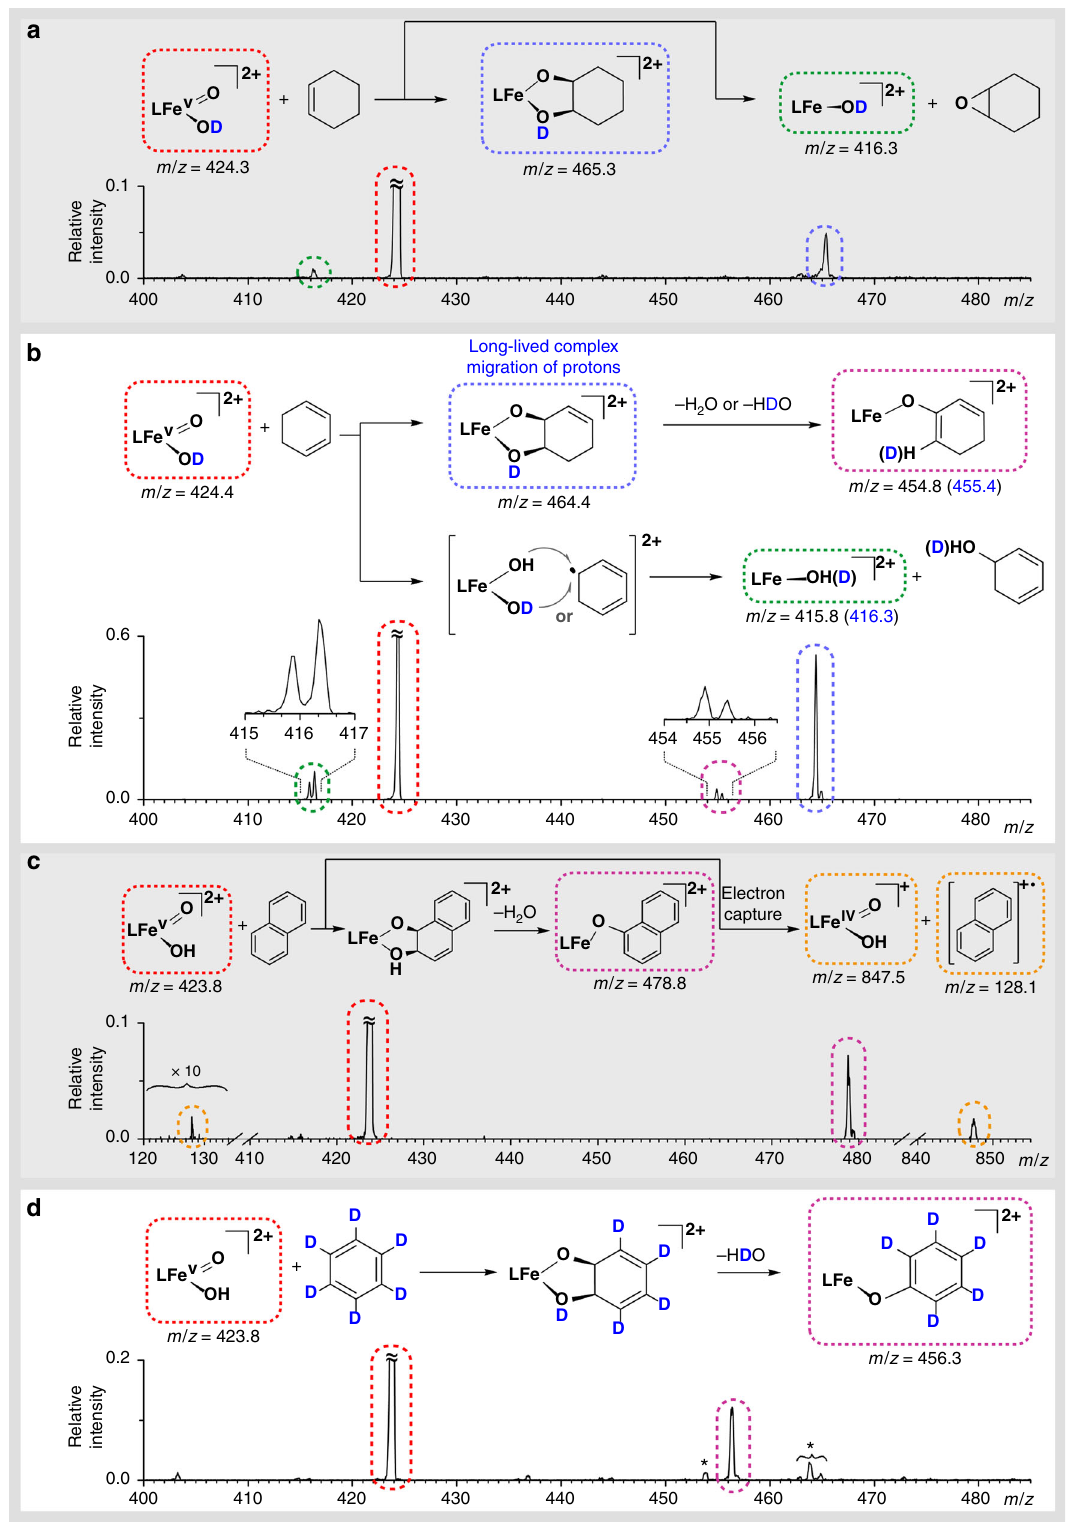
Fig. 4 Ion-molecule reactivity of 3 2 + and 3 2 + ( 2 H) in the gas phase. a 0.1 mTorr of cyclohexene, b 0.1 mTorr of 1,3-cyclohexadiene, c < 0.1 mTorr of naphthalene, and d 0.2 mTorr benzene (asterisks indicate impurities from previous measurements). All reactions were measured at nominally zero- collision energy determined from the retarding potential